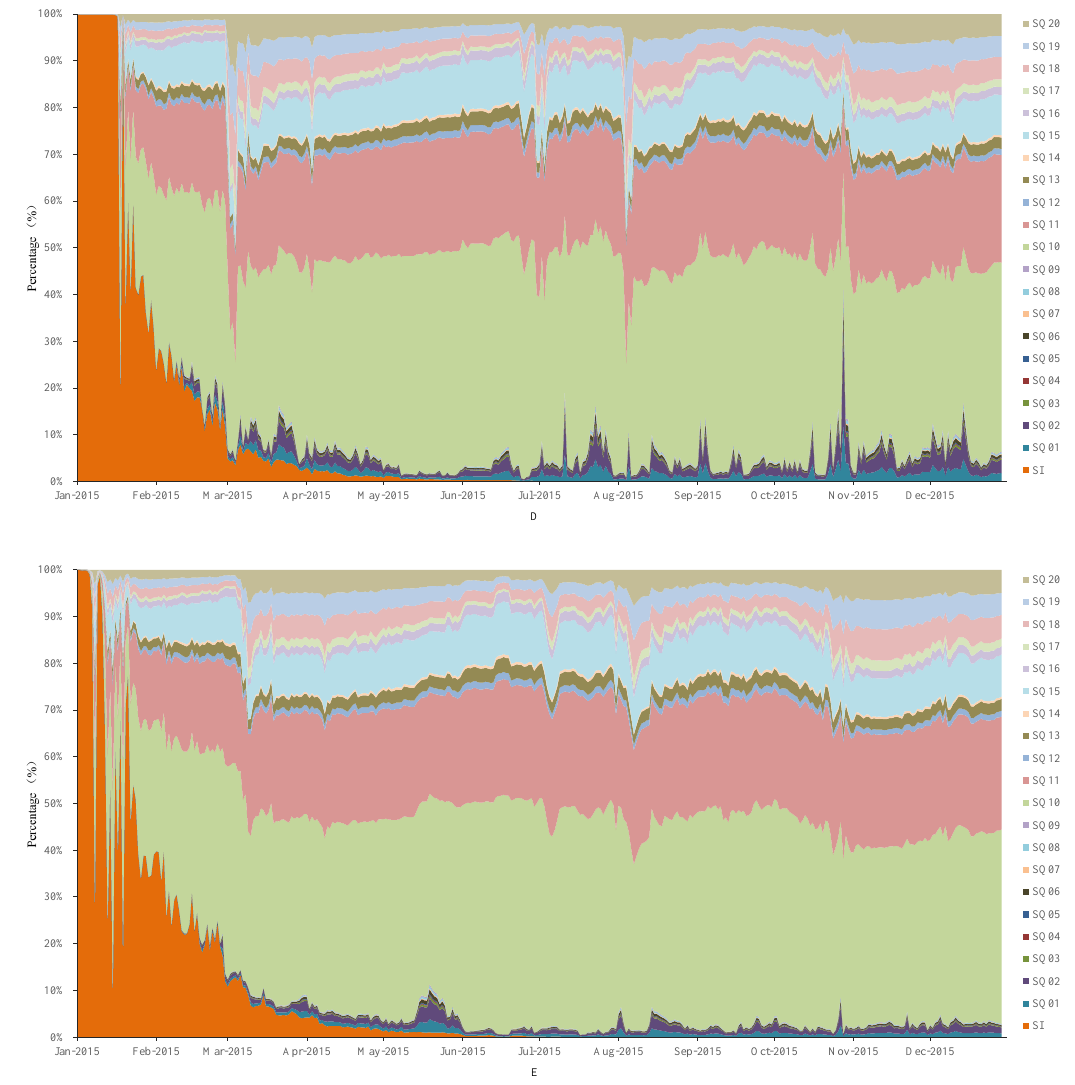
Figure 5. Source contributions to TN pollution at five monitoring points ( A – E ) in Lake Bali. The contributions to TN pollution at the same monitoring point varied over time, and the contributions from the different sources varied across the different monitoring points. Because the input load varies with time, the total load does not always correspond to the source-apportionment result. The contribution of TN pollution at the five points came from the background concentration of the lake at the initial time the model was run, at which time, some pollution sources had not yet reached the response point [22]. Position B is relatively sensitive, and changed first, followed by points A and C. Points E and D changed last. Overall, as the model ran, the impact of the background concentration gradually decreased. However, the impact of the background concentration on one point increased with time. This is because, with the motion of water flow around the point, the impact of background concentration around the point is much greater than that of the input load [22]. It is possible that the impact of background concentration increases when the model simulates mixing of the surrounding water. This is an advantage of the hydrodynamic water-quality model in EFDC [25,26]. As time goes on, the source contributions at some points is clear. The TN concentrations at points A, B, and C in the Northern part of the lake were mainly affected by urban sources and rural sources (SQ01, SQ02, and SQ06) that came from the Shili River sub-watershed. In one year, the contribution rates of SQ01, SQ02, and SQ06 were 27%, 42%, and 9% at point A, and 28%, 43%, and 9% at point B, and 14%,